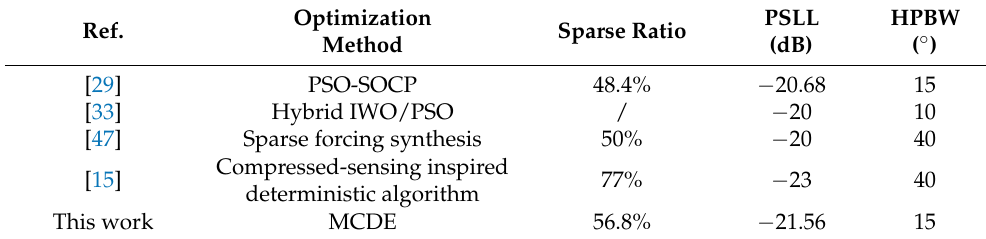
Table 7. The Array in Recent Literature and the Proposed Array. Ref.